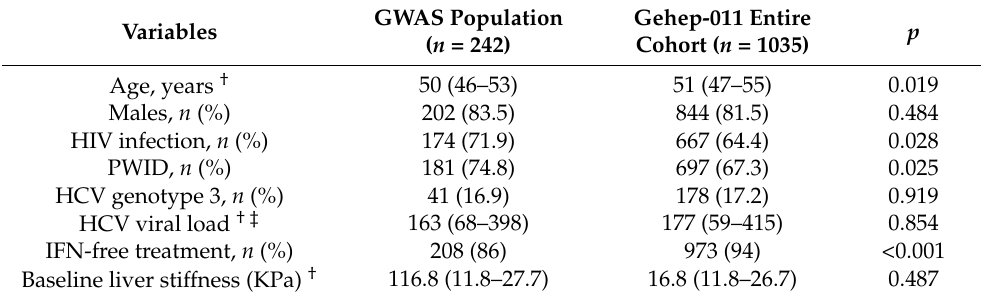
Table 1. Main characteristics of both the study populations and the entire GEHEP-011